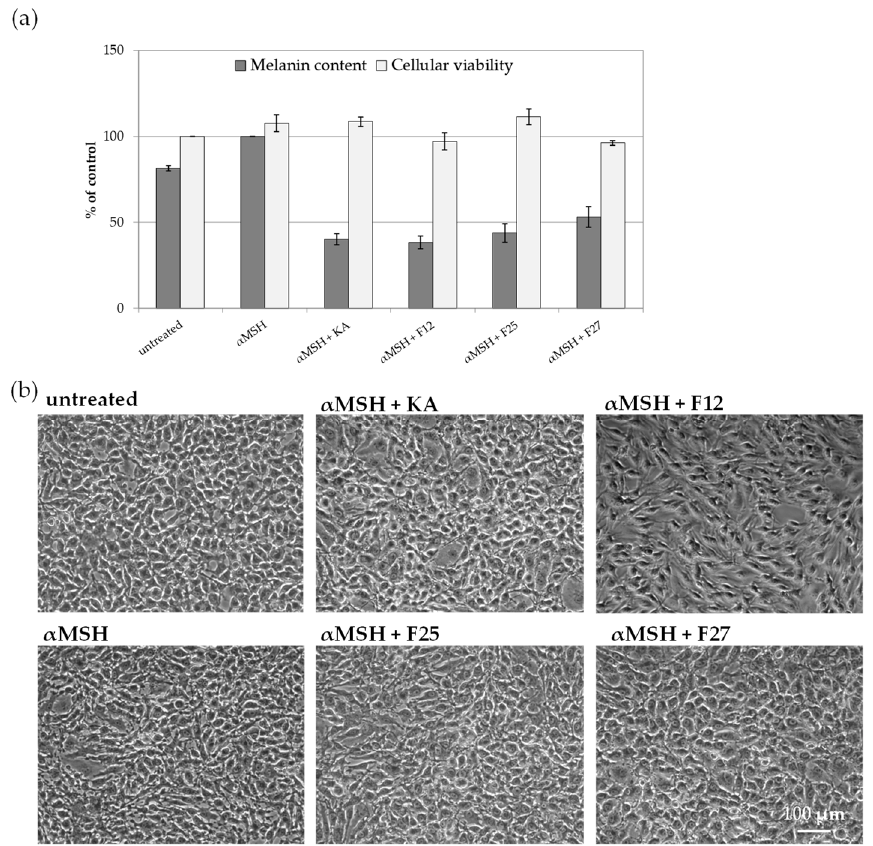
Figure 5. The influence of A. biebersteinii fractions on melanin content and viability of B16F10 murine melanoma cells. ( a ) The relative amount of melanin release into the conditioned medium was measured following 72 hours of culture ± α MSH and 100 µg/mL F12, F25 or F27 A. biebersteinii fractions. Cellular viability was assessed by the Neutral Red Uptake Test. The graph shows mean ± SD, n = 2; ( b ) morphology of B16F10 cells following 72 hours of culture ± α MSH and F12, F25, or F27, 10 × magnification, pictures are representative for two independent experiments.